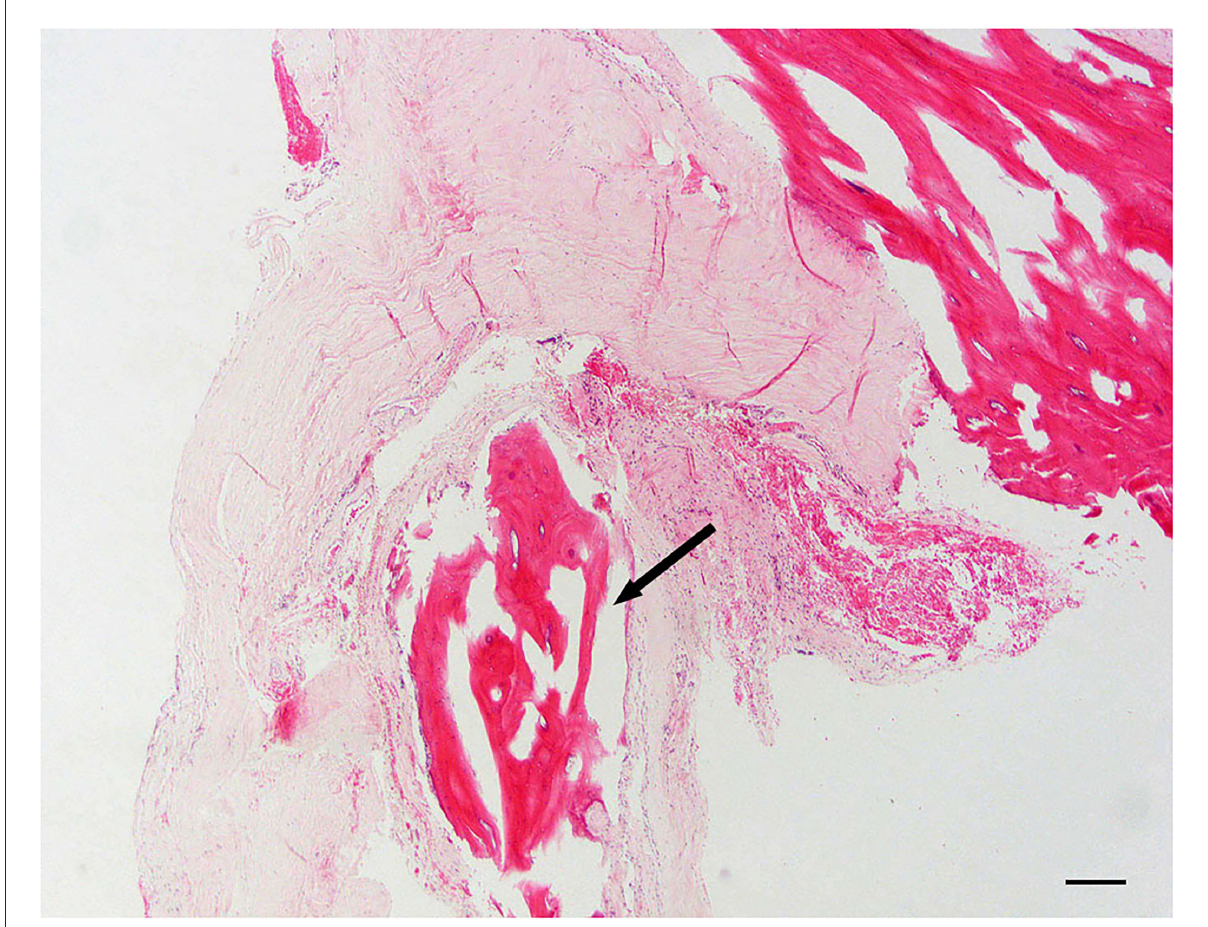
FIGURE5 Dural osseous metaplasia; 10 × –Scale bar = 100 microns; Arrow indicates osseous metaplasia.